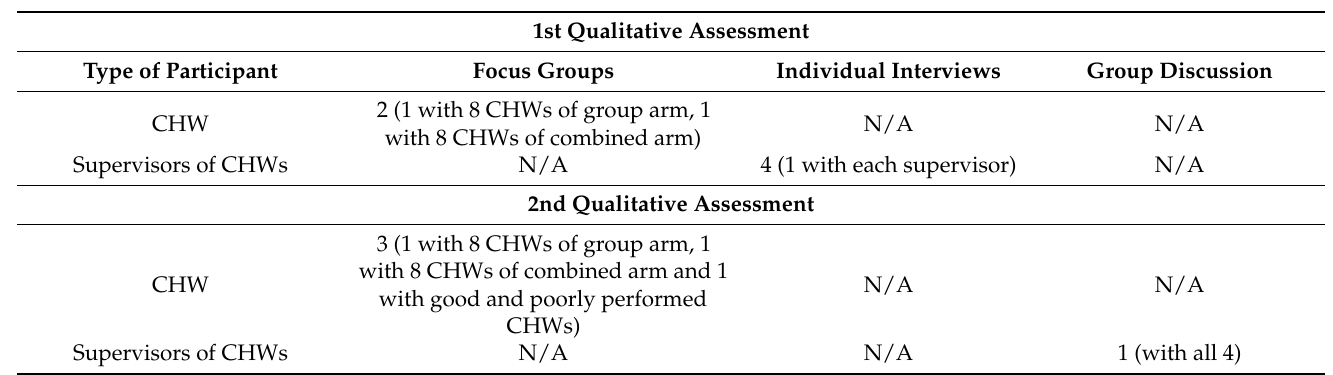
Table 3. Participants of qualitative